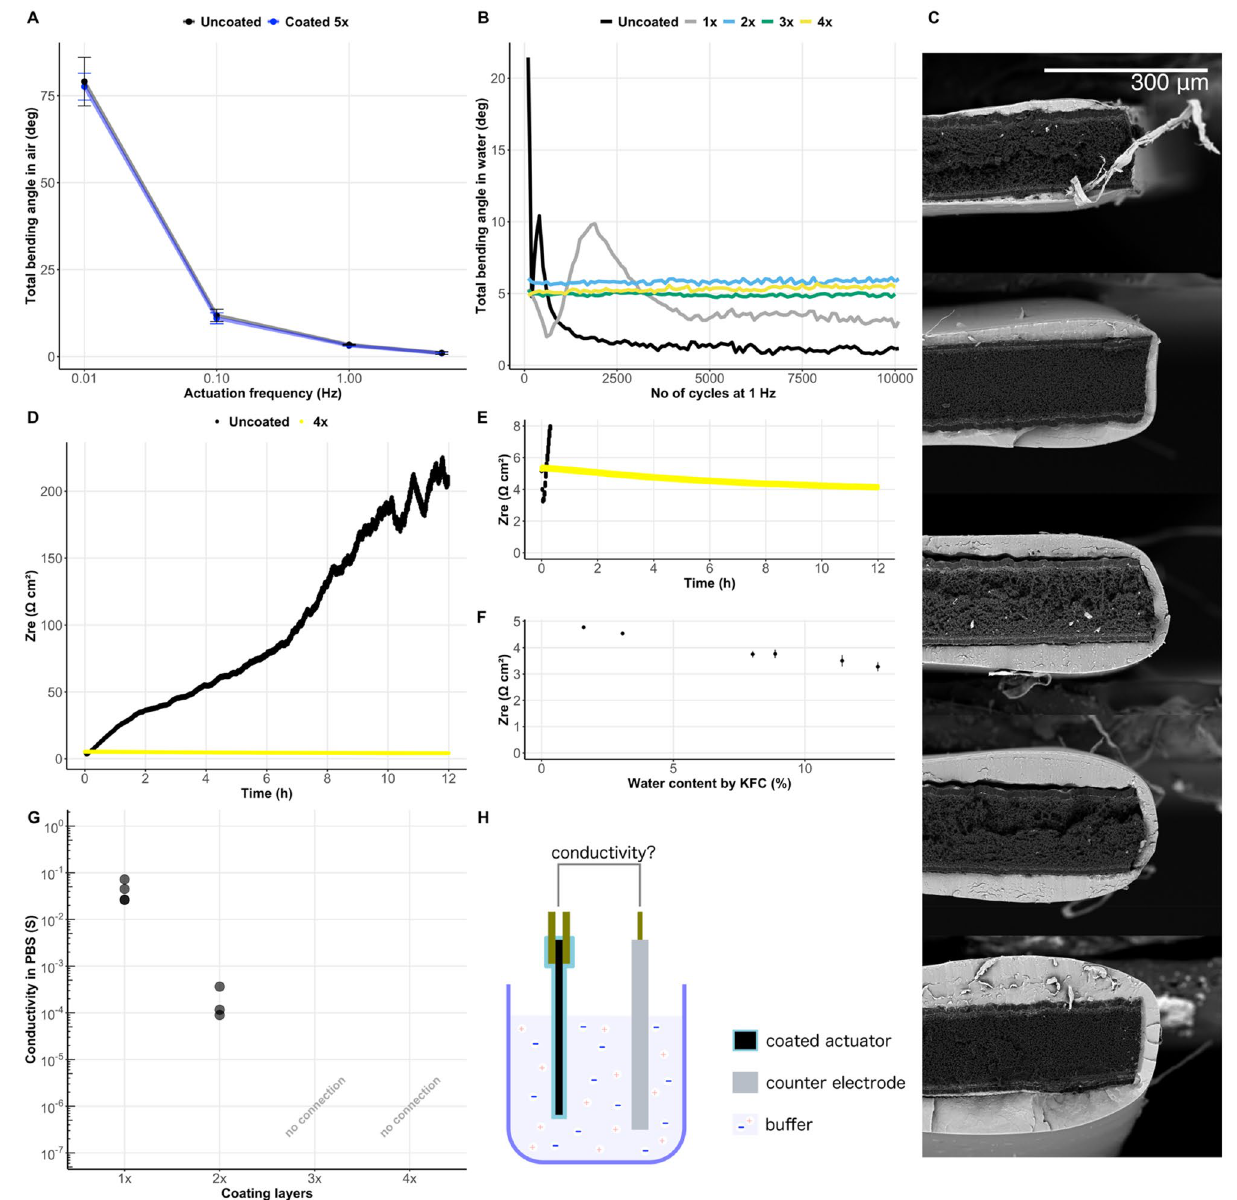
Figure 3. Performance evaluation. Five coating layers show only negligible impact on total maximum deflection of the actuator compared to an uncoated one ( A ). Error bars show one standard deviation of the mean of samples (n s = 4) and cycles (n c = 5). Starting from two coating layers there is no visible change in the maximum amplitude during operation in water over the first 10,000 cycles ( B ). Each dip-coated layer adds to the total coating thickness because the solvent dissolves previously added layers very slowly, as can be seen from SEM images of PPy actuator cross-sections with 1 to 5 added layers ( C top (1 layer) to bottom (5 layers)). Monitoring electrochemical impedance through the actuator that is submerged in water (500 mL MilliQ) shows electrolyte leach out of the sample in case of uncoated samples and only a small increase in conductivity in case of 4 coating layers ( D ). Small increase in conductivity could be attributed to the reduced viscosity of the electrolyte due to water vapor leaching in the sample ( D–F ). Further studies of the coating permeability while the sample is submerged in a conductive liquid (phosphate-buffered saline) and electrochemical impedance against an external counter electrode ( H ) is measured indicate that three coating layers was sufficient to electrically seal the sample from external electrolytes ( G ), while a small amount of water is still able penetrate the coating due to the characteristic WVTR of SIBS ( D–F ). Sample size in all experiments was 20 (18) mm × 1 mm × 150 µm (L × W × T) with 2 mm mounted between gold contacts and 18 mm free to bend. All samples (excluding uncoated references) were coated with 5% (w/w) SIBS in 2,2,4-trimethylpentane in solvent atmosphere at 1 mm/s dipping and withdrawal